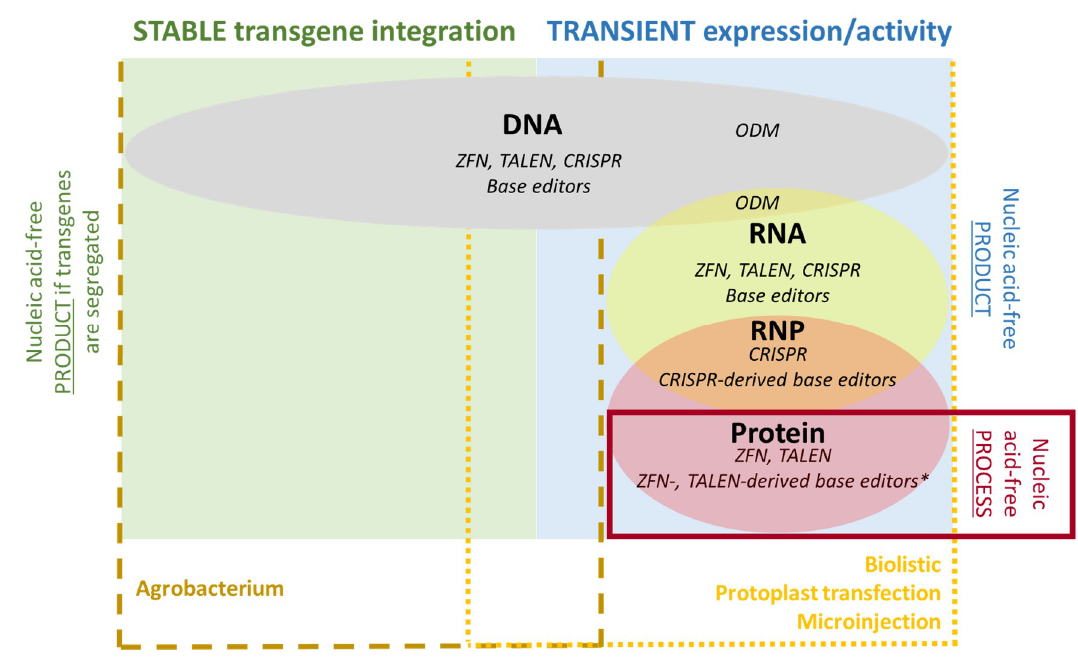
Figure 2. Representation of the relationships between genome-editing tools, delivery methods, and outcomes. The figure shows which tools can be delivered as DNA, RNA, RNPs, or proteins, and which delivery methods are suitable for each cargo type. It also indicates which cargo and delivery methods are available for stable transformation and transient expression, and categorizes them according to the use of nucleic acids (which is relevant for the regulatory assessment of generated plants). The sizes of the shapes are intended to promote visual clarity and do not indicate any relative importance among the